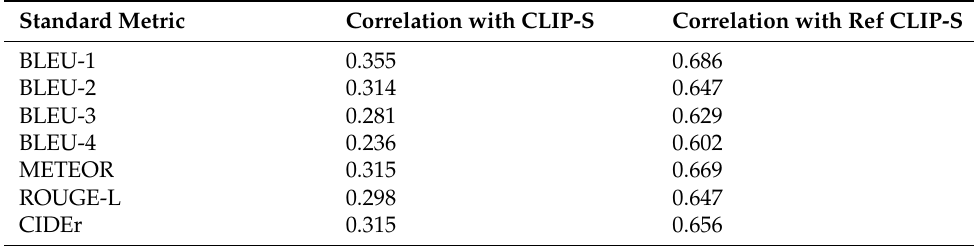
Table 2. Spearman’s correlation coefficients between the values of standard and new metric scores on the Iconclass Caption test set ( p -value < 0.001).